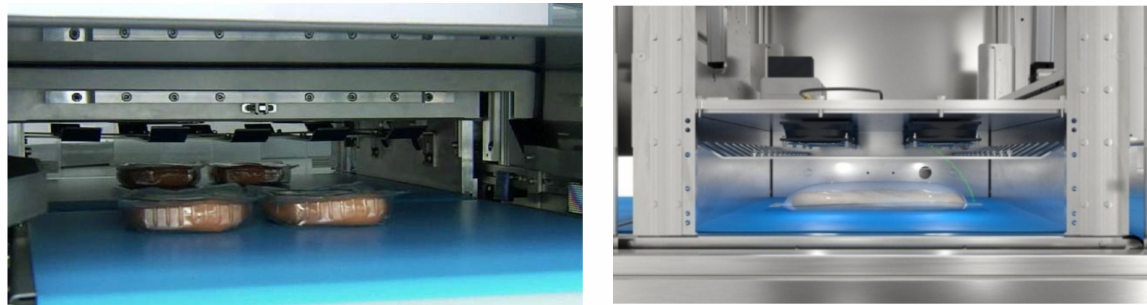
Figure 12. 100%, non-destructive control of packaging tightness in-line device Leak Master MAPMAX ®®® (interior), reprinted with permission from WITT